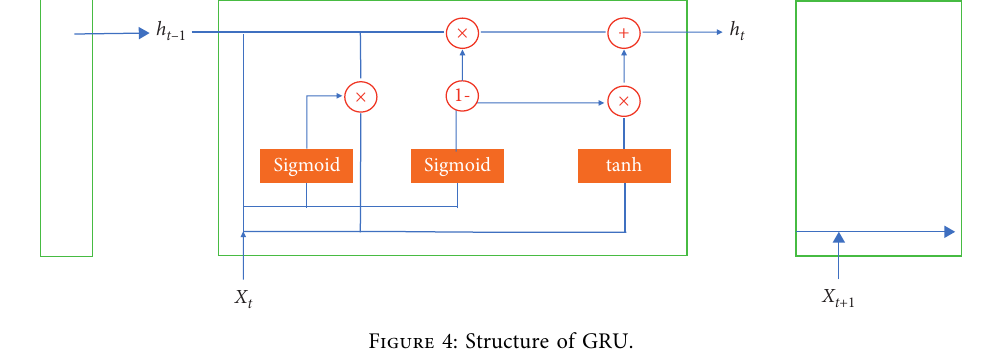
Figure 4: Structure of GRU.